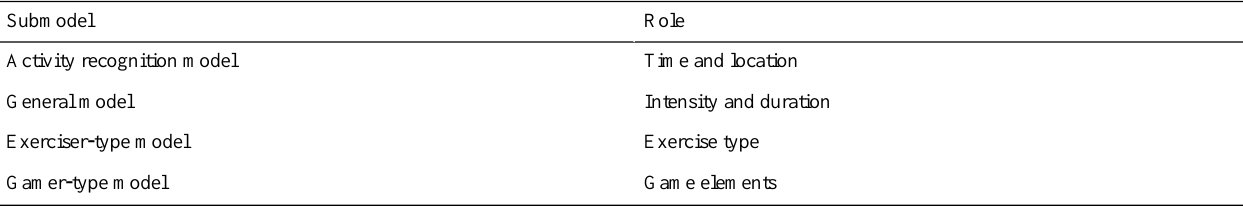
Table 1. The roles of each submodel.